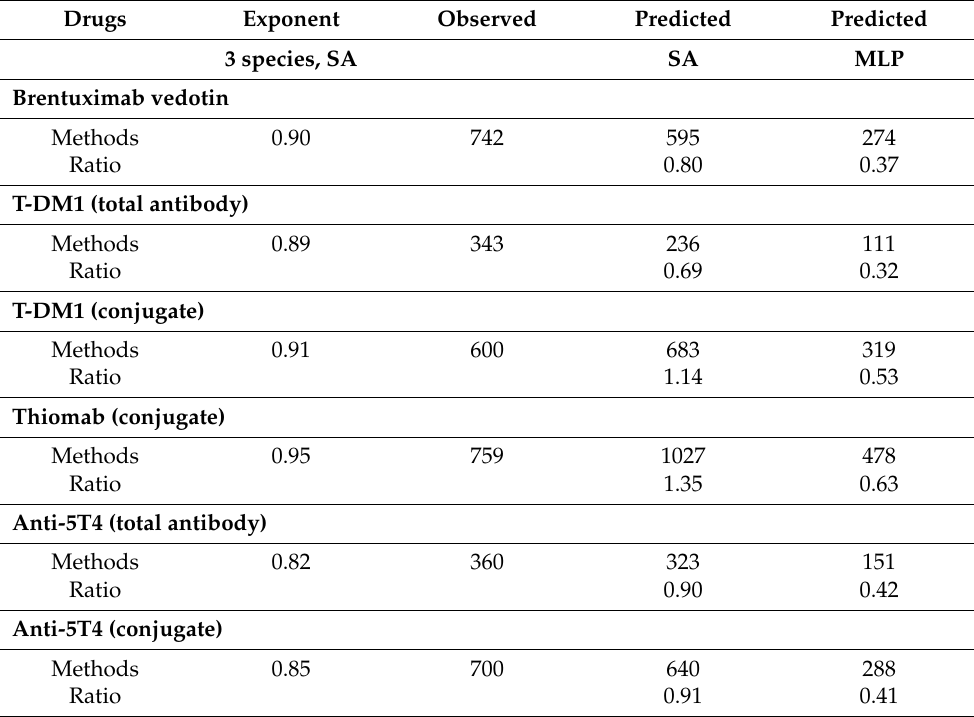
Table 3. Predicted and observed clearances of ADCs by simple allometry (SA) and maximum life-span potential (MLP) using three animal